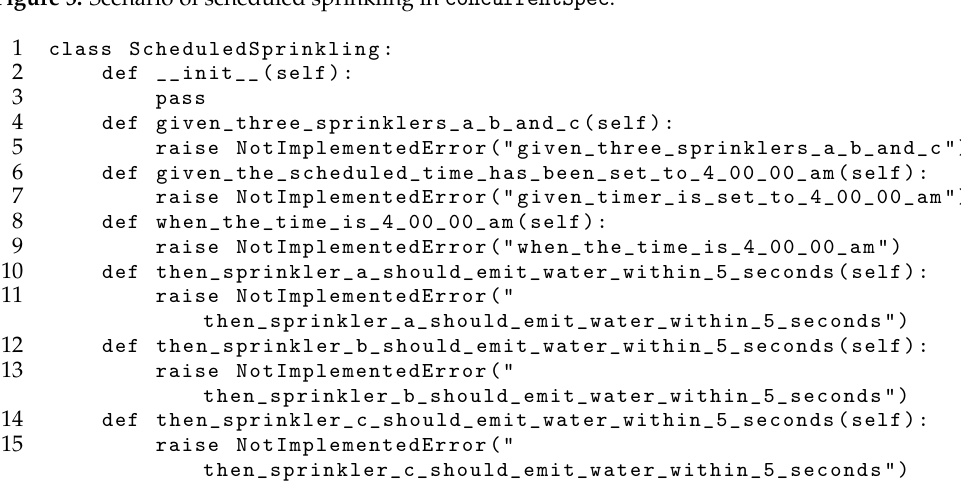
Default step definition of the scheduled sprinkling scenario generated in